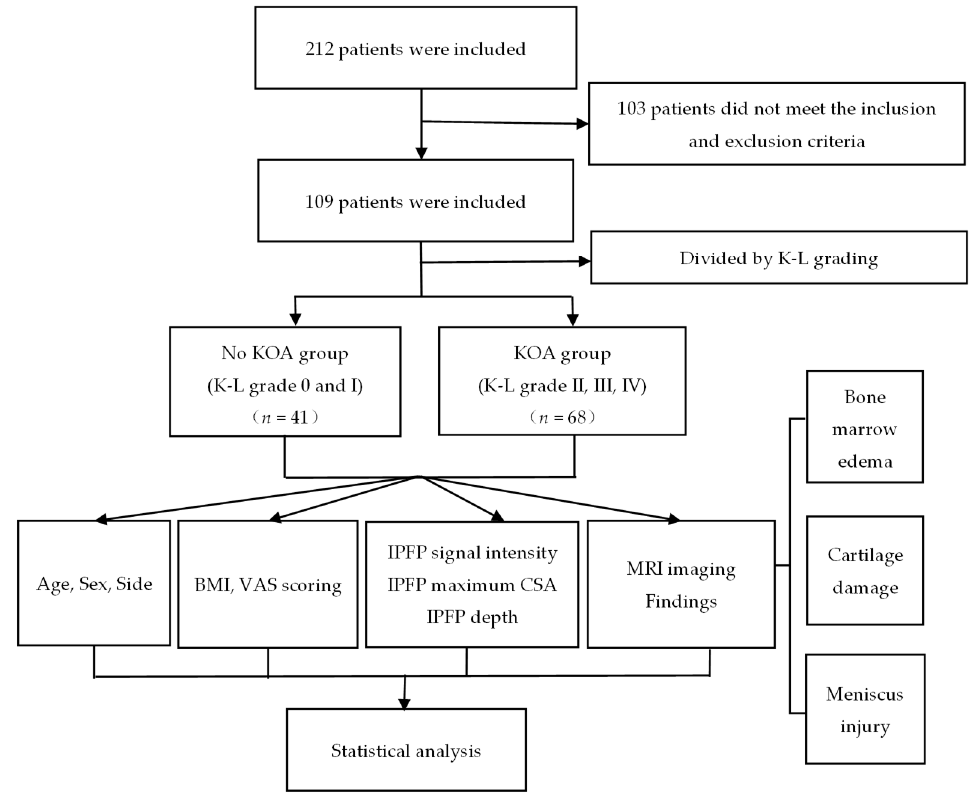
Figure 1. Patient’s flow chart. Patient profiles and the groups included in the study. K-L, Kellgren- Lawrence; KOA, knee osteoarthritis; BMI, body mass index; VAS, visual analogue scale; CSA, cross-sectional area; MRI, magnetic-resonance imaging.